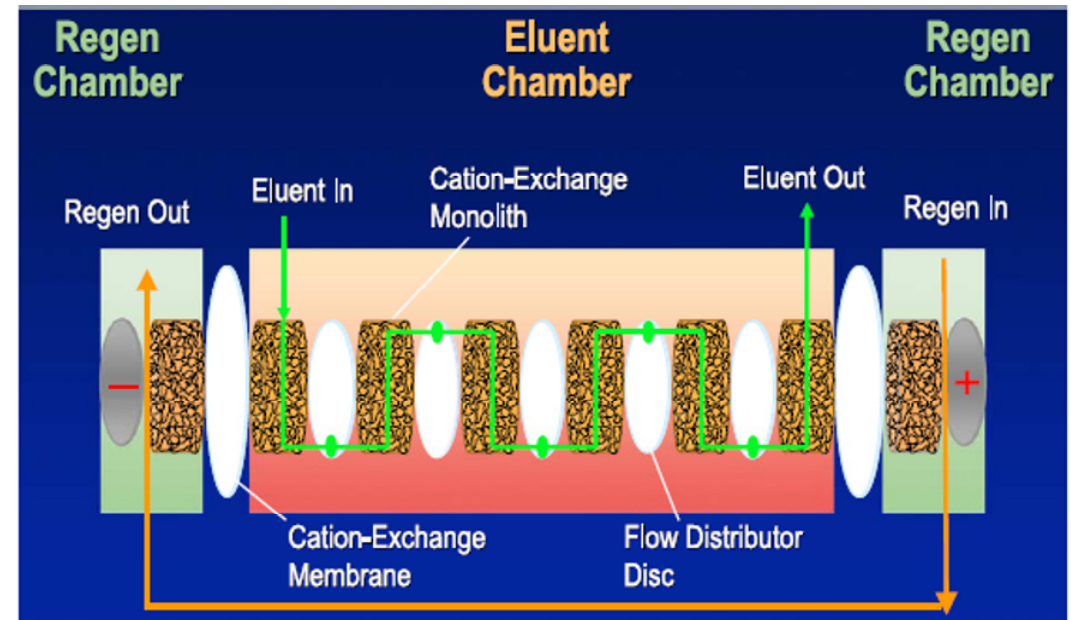
Figure 2. The scheme of Atlas ® electrolytic